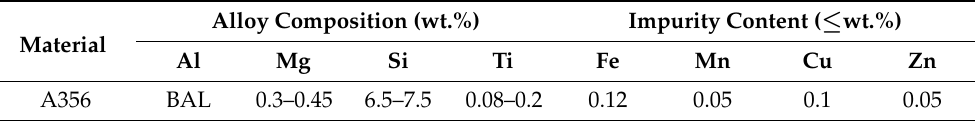
Table 1. The chemical composition of